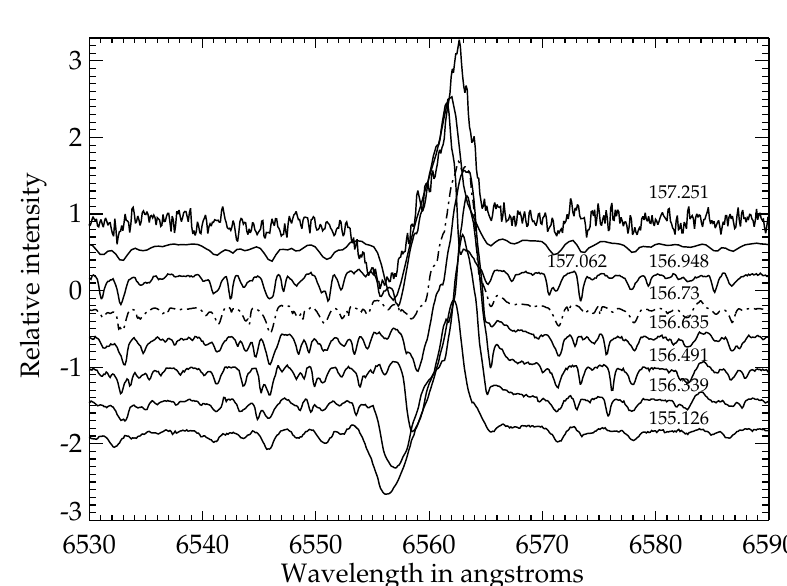
Fig. 7. The region of υ Sgr spectra near the H α line during the radial velocity cycle 156 (Be star database). The spectrum from the NARVAL database is indicated by a dash-dotted line. The cycle number and phase according to ephemeris by Koubsk(cid:19)y et al. (2006) is indicated for every observation.